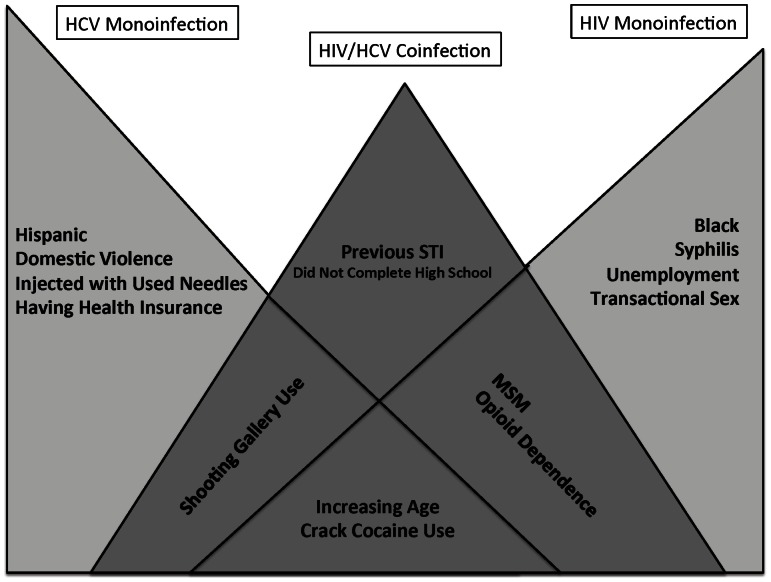
Graphical Representation of Overlapping Relationships Between HIV/HCV Coinfection, HCV Monoinfection and HIV Monoinfection, 2003-2011.(N = 7473) MSM  =  Men-Who-Have-Sex-with-Men; STI  =  Sexually Transmitted Infection.